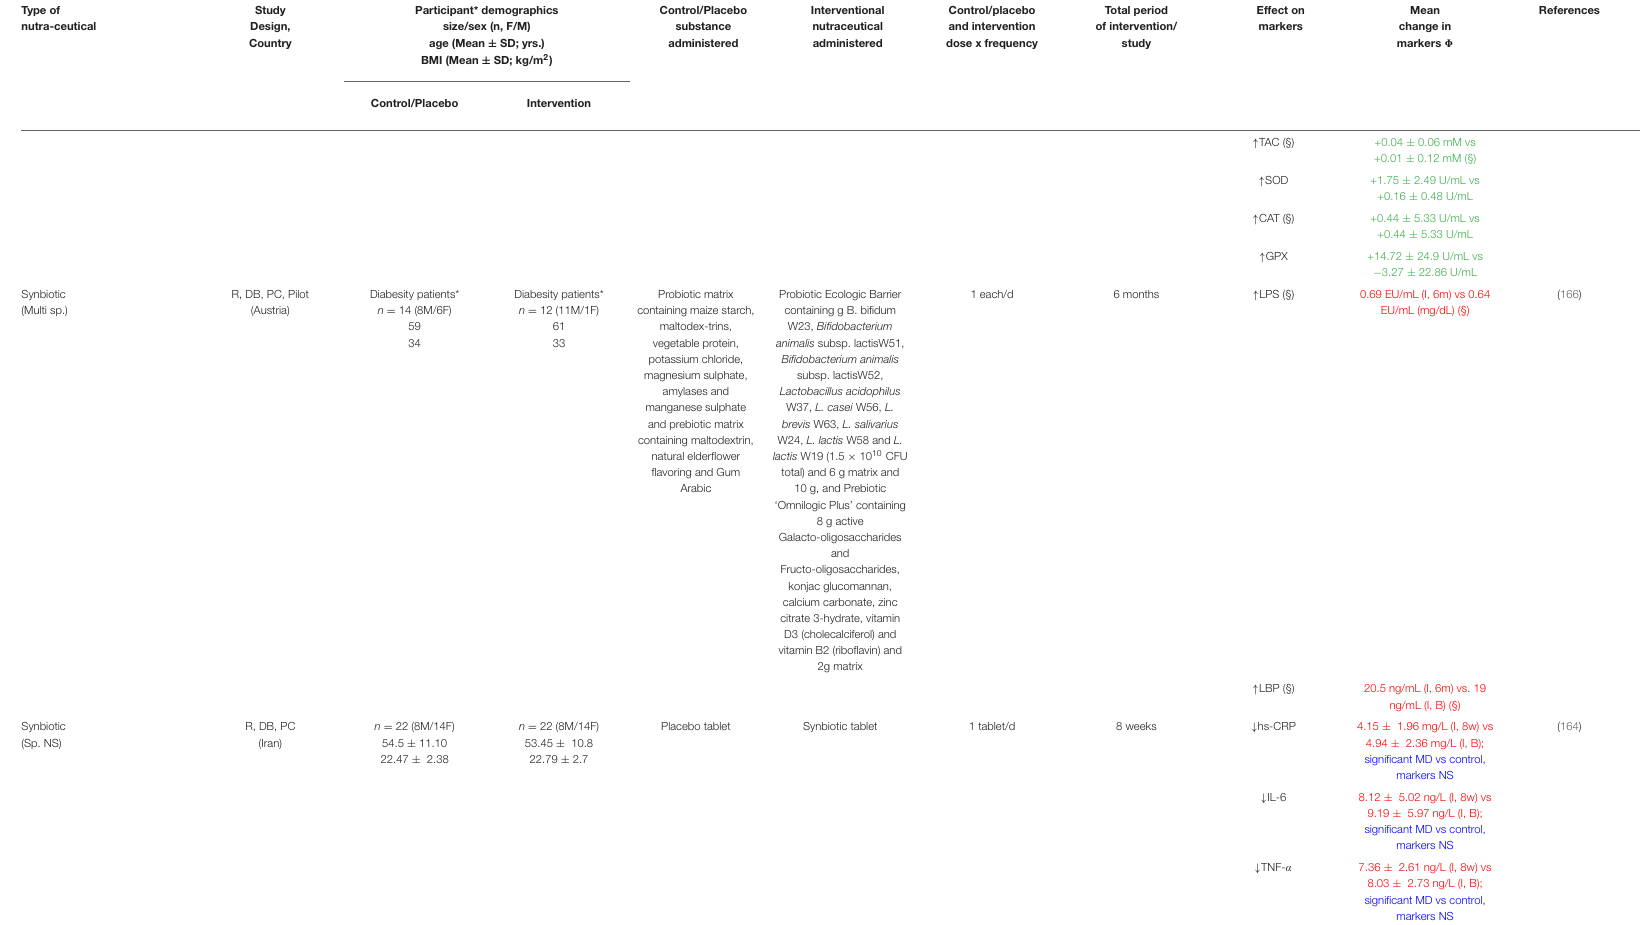
*All participants are T2D-diagnosed patients, unless otherwise stated; ↓ indicates a decrease in value; ↑ indicates an increase in value; • = No change in value; (cid:56) = Order of markers compared = those of Intervention (I) group first, Control (C) or baseline (B) second; Text color represents comparison body as follows, Blue = Comparison of effective change due to intervention by adjusted Mean Difference (MD) of changes in markers observed between I&C groups at end of the study from baseline; Green = Comparison of changes in I vs. C groups at the end of study from respective baselines; Red = Comparison of change (or difference) in markers at the end of study from baseline in I group; § = Non-significant Result; T2D = Type-2 Diabetes; NS = Not Specified; NR = Not Reported; Sp. = Species; SB = Single-Blinded; DB = Double-Blinded; TB = Triple- Blinded; R = Randomized; RCT = Randomized Controlled Trial; CC = Crossover Controlled; PC = Placebo-Controlled; PG = Parallel Group; CT = Clinical Trial; OL = Open Label; MDA = Malondialdehyde; IL-6 = Interleukin 6; TNF- α = Tumor necrosis factor alpha; CRP = C-reactive protein; SCFA = Short-Chain Fatty Acid; NAFLD = Non-Alcoholic Fatty Liver Disease; GSH: Glutathione; GSSG = oxidized glutathione; Hs-CRP: High sensitivity C-Reactive Protein; CAT = Catalase; TAC = Total Antioxidant Capacity; TAS = Total Antioxidant Status; LPS = lipopolysaccharide; LBP = lipopolysaccharide binding protein; IL-1ra = IL-1 receptor antagonist SOD = Superoxide Dismutase; GPX = Glutathione Peroxidase; GR = glutathione reductase; HP = High Performance; F2-iso = F2-isoprostane; IFG = impaired fasting glucose; IGT = impaired glucose tolerance; NGT = normal glucose